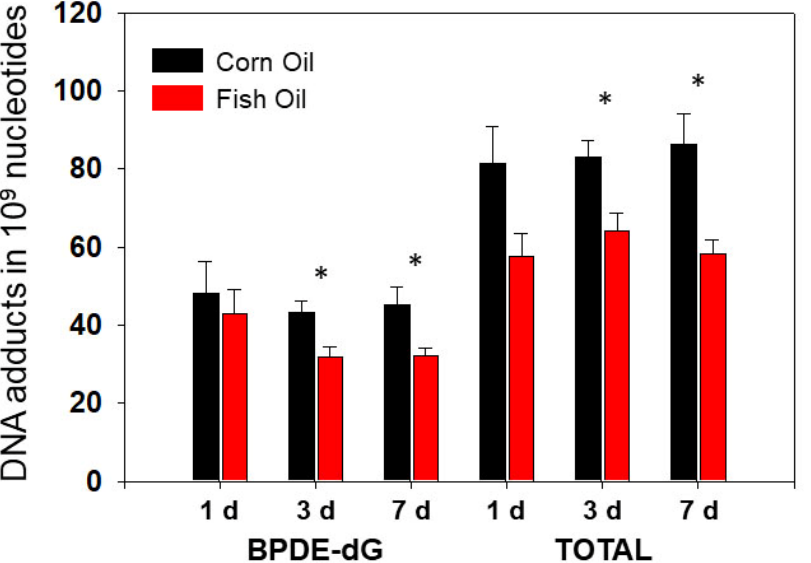
Figure 2. Effect of dietary fish oil on pulmonary DNA adduct levels. Dietary fish oil significantly decreased PAH-DNA adducts compared to CO diet at 3 and 7 days after treatment of high dose of PAH mixture, but not at 1 day. *, p < 0.05 ( n = 4–5, one-way ANOVA).